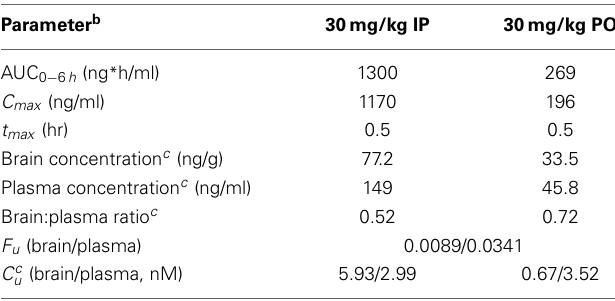
Table 2 | Pharmacokinetic datafor LY2424100 a